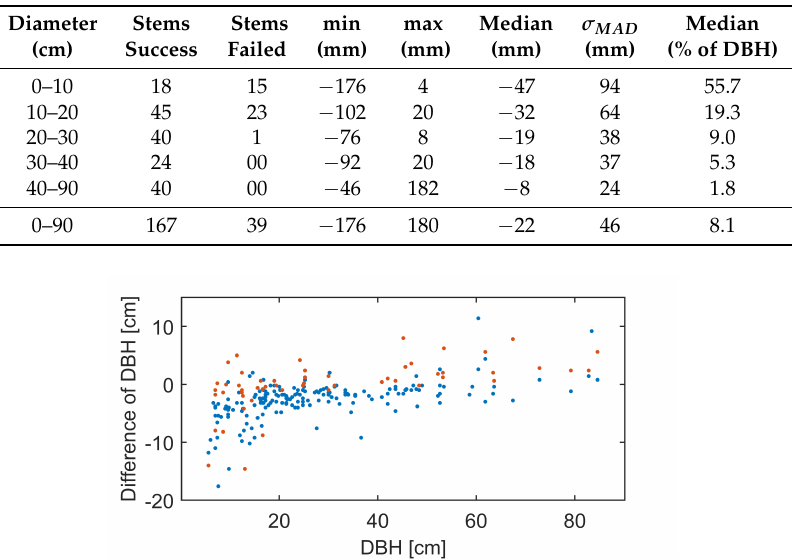
Table 2. Nominal-actual comparison of in situ measured and from ULS modeled DBH (DBH differences: field minus ULS) for all available in situ measurements. “Stems failed” indicates that the cylinder fitting was not successful.